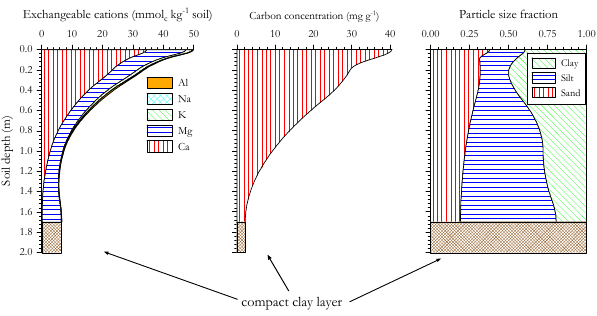
Fig. 13 Fig. 13. Profiles of exchangeable cations, soil carbon and texture for a Vetic Nitisol (Hypereutric, Rhodic) in Bolivia (HCC-22).